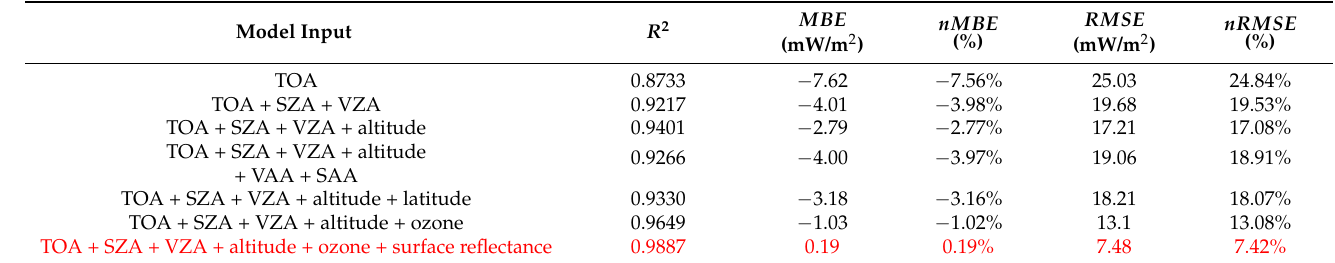
Table 2. Performance evaluation of the deep residual fully connected network plus random forest (DRFCN+RF) model under different parameter combinations. The best combination is marked in red. “TOA” refers to the spectral top-of-atmosphere (TOA) reflectance in the Moderate Resolution Imaging Spectroradiometer (MODIS) bands.